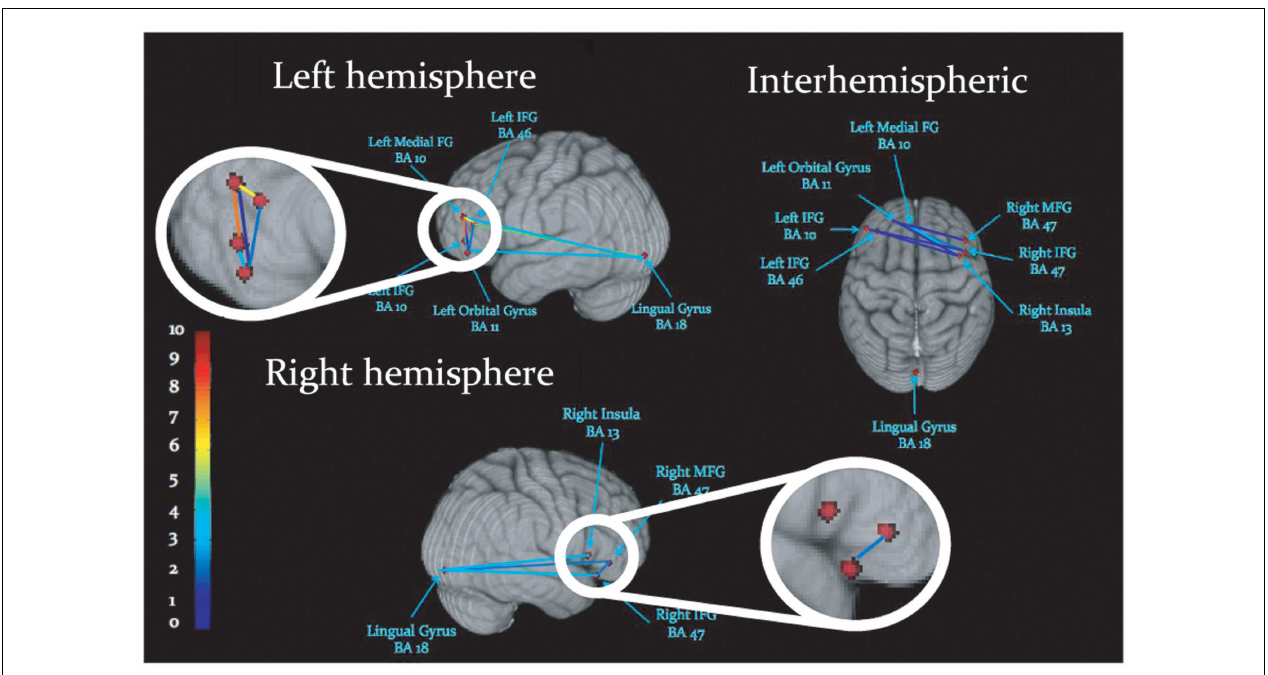
FIGURE 3 | Schematic display of inter-regional synchronization, where dots represent peaks of cortical activation, and lines reflect gamma-band synchronization among activated regions. Colors reflect the number of statistically significant synchronizations, legend at